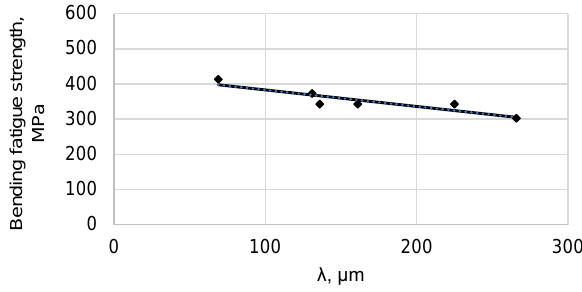
Figure 3: Bending fatigue strength of steel hardened and tempered at 400 ∘ C subject to impurities space